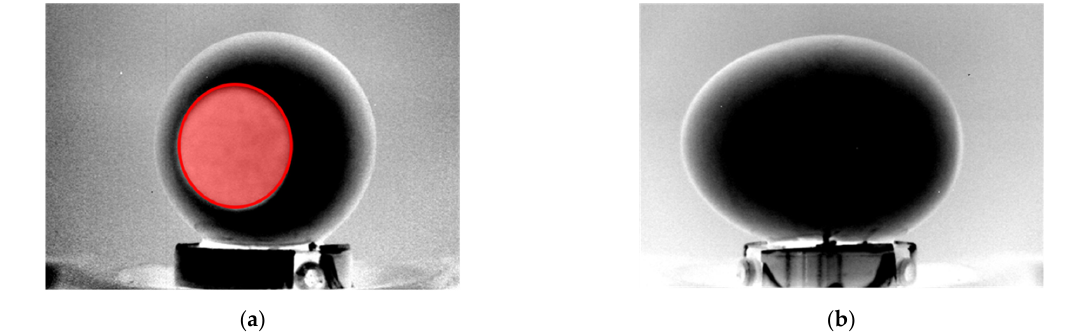
Figure 11. ( a ) Front and ( b ) lateral views of egg M#9: in the lateral view, the air chamber does not appear.